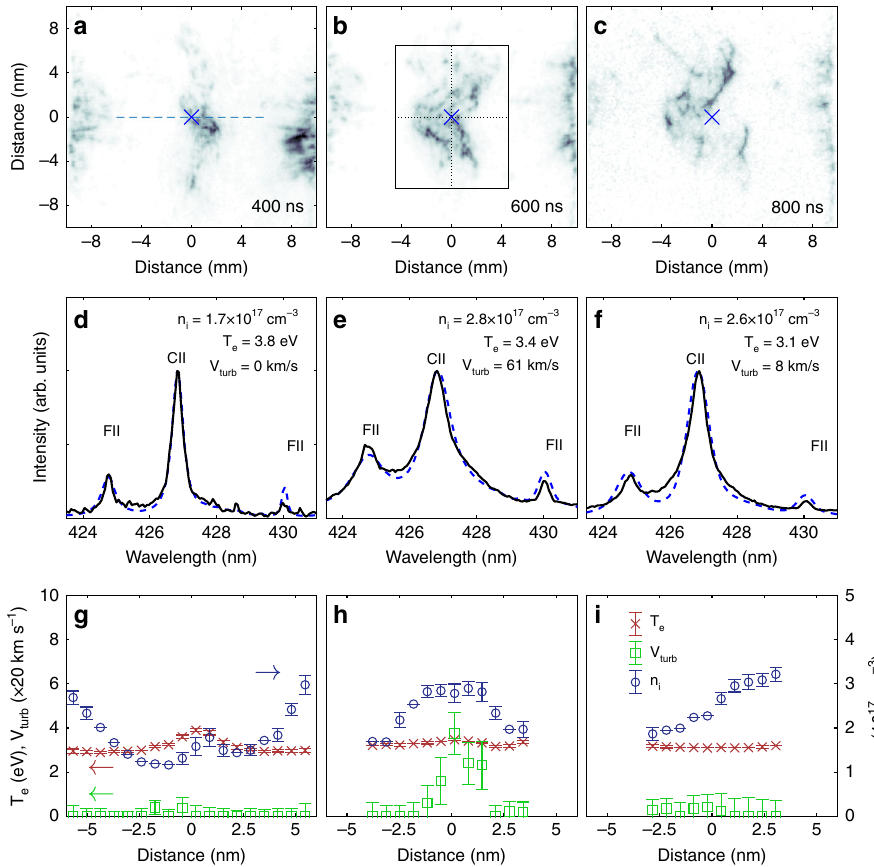
Fig. 2 Schlieren images and optical emission spectroscopy data. Schlieren images taken at a 400ns, b 600 ns, and c 800 ns after the peak of the drive laser. The box in panel b shows the region over which the density power spectra, shown in Fig. 3a – c, are calculated. Panels d – f show experimental emission spectra (solid black lines) from the regions marked by × in panels a – c , along with the best- fi t theoretical spectrum (blue-dashed lines). The parameters given correspond to the plotted theoretical spectrum. Panels g – i show corresponding pro fi les of temperature (red crosses), density (blue circles), and turbulent velocity (green squares) across the region indicated by a dashed line in panel a , as inferred from the optical emission spectroscopy. The error bars represent a 10% deviation between the calculated and measured emission